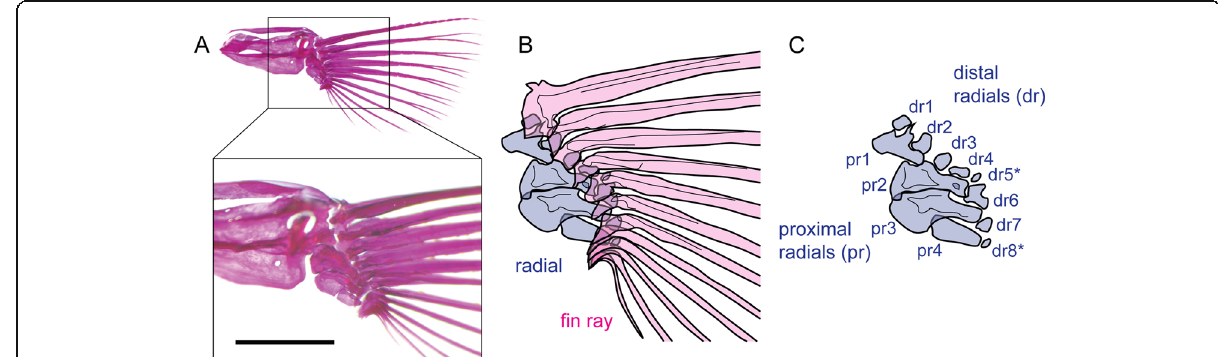
Fig. 1 Skeletal anatomy of the zebrafish pectoral fin. a Skeletal anatomy of the zebrafish pectoral fin with Alizarin Red staining. The bottom box shows a magnified view of the upper whole pectoral fin skeleton in the inset. The scale bar indicates 1 mm. b , c Schematics of the fin rays and radials. Drawings in dark blue and pink indicate radials and fin rays, respectively. Each of the proximal radials (pr) and distal radials (dr) are indicated in c . dr5, and dr8 occasionally did not appear